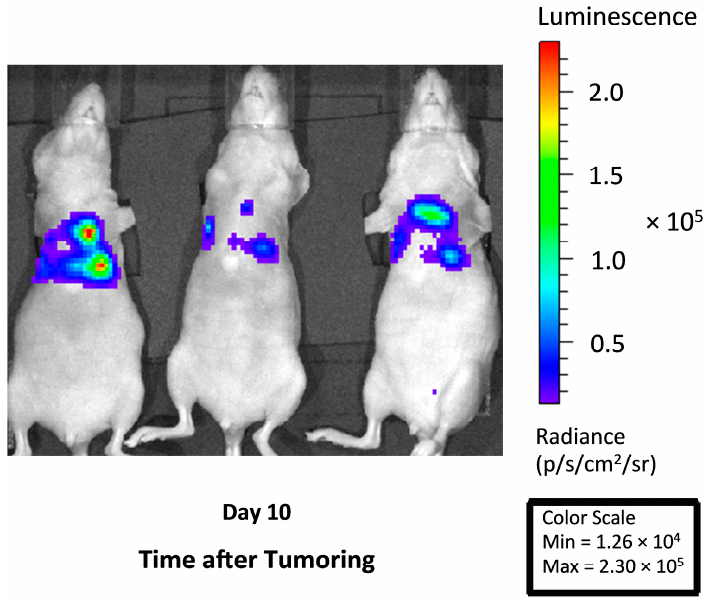
Figure 1. In vivo bioluminescent imaging demonstrates thoracic tumor burden in representative animals. Images taken at 10 days after the injection of H460 tumor cells and illustrates the thoracic spread of disease that includes areas of focal